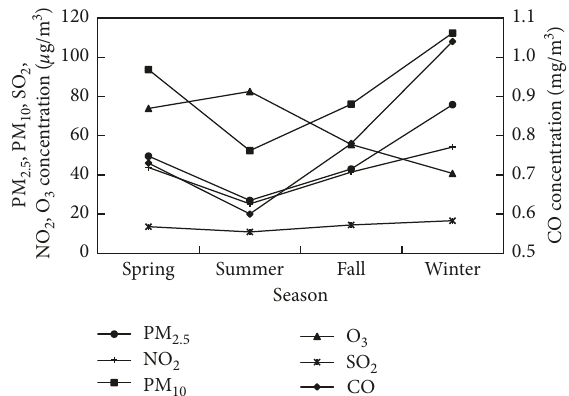
Figure 8: Seasonal concentration values of primary air pollutants in Jiangsu Province between September 2017 and August 2018. Unit: PM 2.5 , PM 10 , SO 2 , NO 2 , and O 3 : μ g/m 3 ; CO: mg/m 3 .